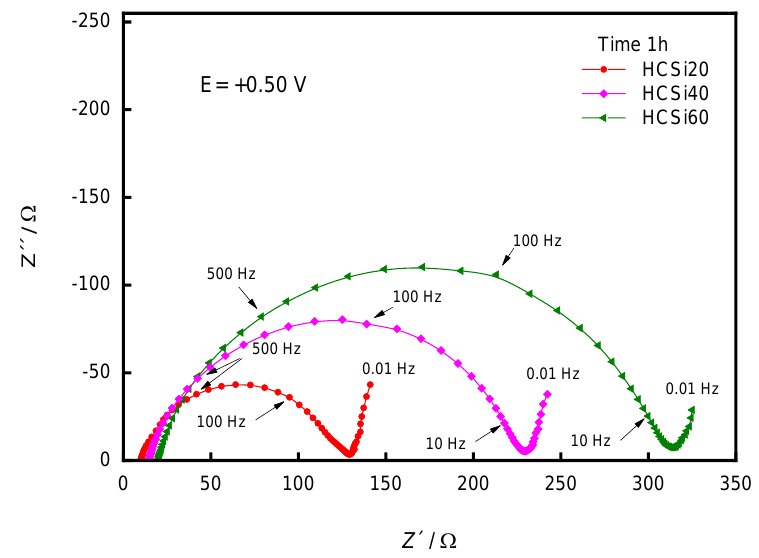
Figure 10. In situ GEIS impedance spectra compared for all three thicknesses with FEC in Nyquist